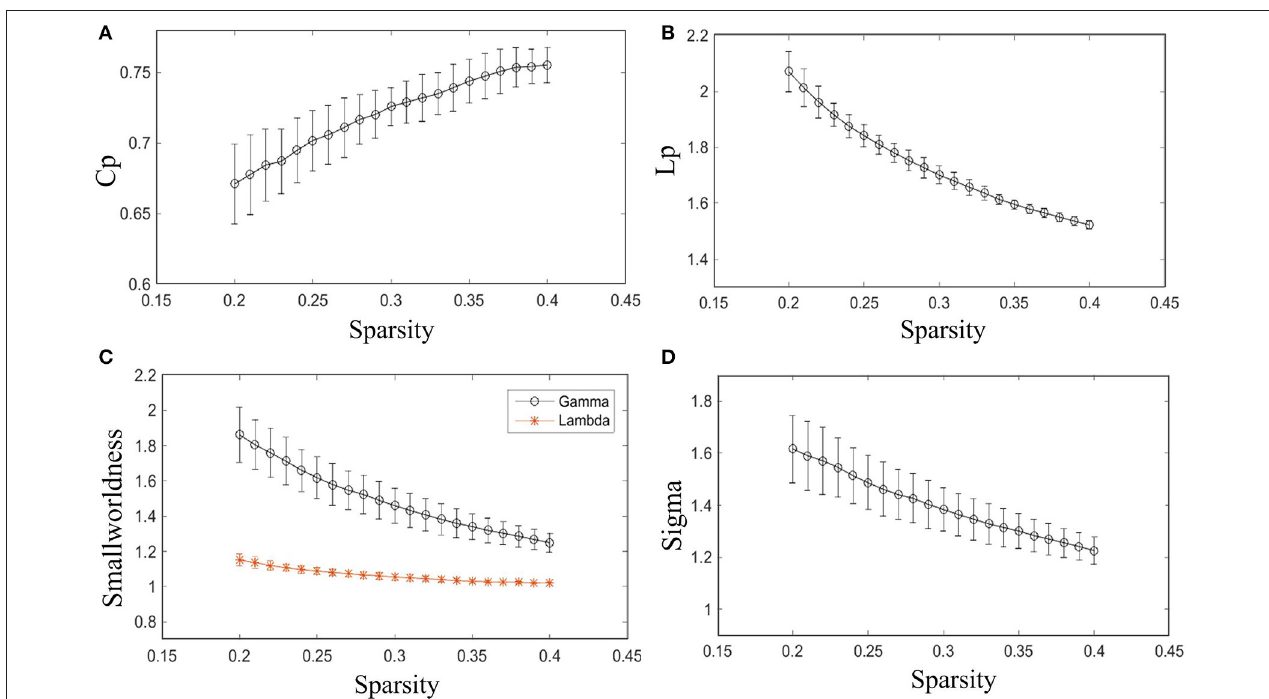
FIGURE 2 | Small-world configurations of the individual morphological brain network. (A–D) The average Cp, Lp, γ , λ , and σ of the subjects for each sparsity (from 20 to 40% with a step size of 1%). The error bar indicates the standard deviation caused by different subjects.